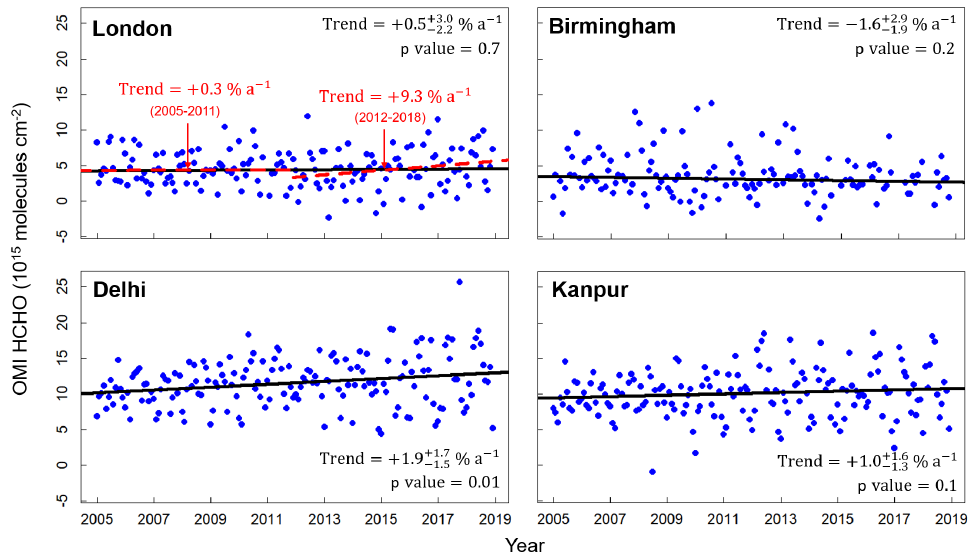
Figure 9. Time series of OMI HCHO for London, Birmingham, Delhi, and Kanpur. Points are city-average monthly means of OMI HCHO after removing the background contribution (see text for details). Solid black lines are trends for 2005–2018 obtained with the Theil–Sen single median estimator. Values inset are annual trends and p values. Absolute errors on the trends are the 95% CI. Dashed red lines show trend lines for London in 2005–2011 and 2012–2018, and red text shows corresponding annual